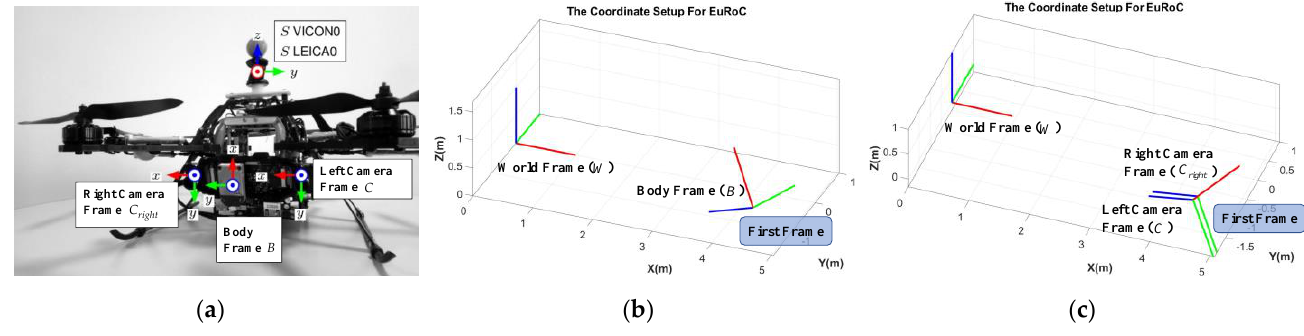
Figure 1. Coordinate setup: ( a ) Illustration of coordinate setup on UAV (modify from [27]); ( b ) Illustration of world frame and body frame; ( c ) Illustration of world frame, right camera frame, and left camera frame.